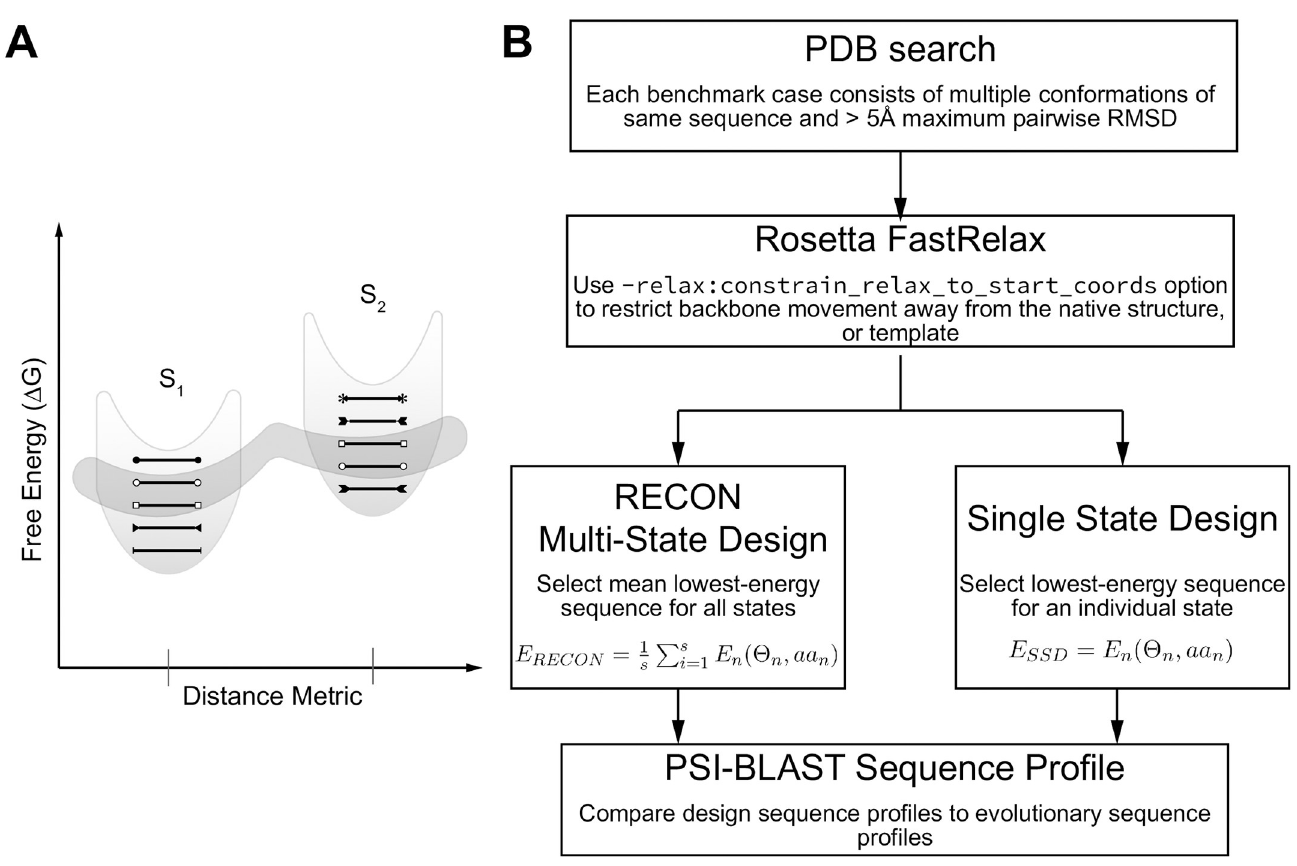
Fig 1. Graphical representation of hypothesis and experimental design. (A) Schematic of sequence space and the impact of flexibility on sequence tolerance. S 1 and S 2 represent two unique conformations of the same residue length separated by some RMSD that populate two local energy minima. Black lines with end caps represent unique sequences that are energetically most favorable for a single conformation. The dark shaded area encircles sequences that are energetically favorable for both conformations. Here we illustrate that by using multiple conformations during protein design, we identify sequences that are energetically suitable for conformational flexibility, yet are not necessarily the most stable sequence for any given conformation. Additionally, the requirement to adopt multiple conformations constrains the number of suitable sequences (B) Flow chart of benchmark